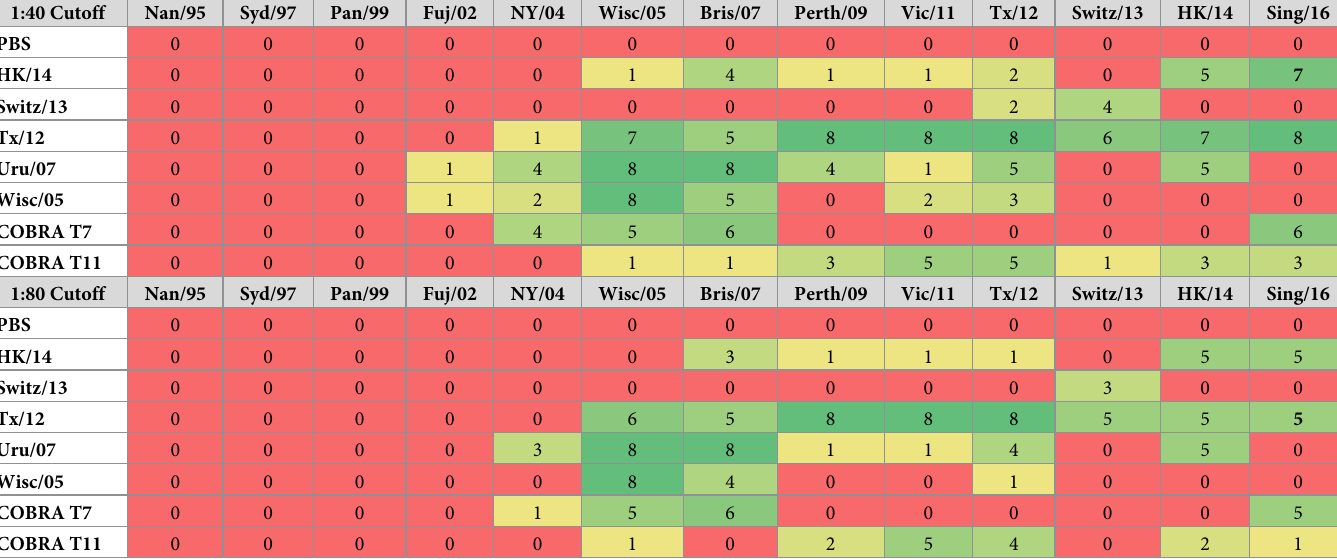
Numbers represent the number of animals from each group that achieved an antibody titer � 1:40 in the (top table) and � 1:80 (bottom table) against 13 historical H3N2 vaccine strains. Colors range from red representing 0 animals achieving the designated titer to dark green representing when all 8 animals surpassed the antibody titer